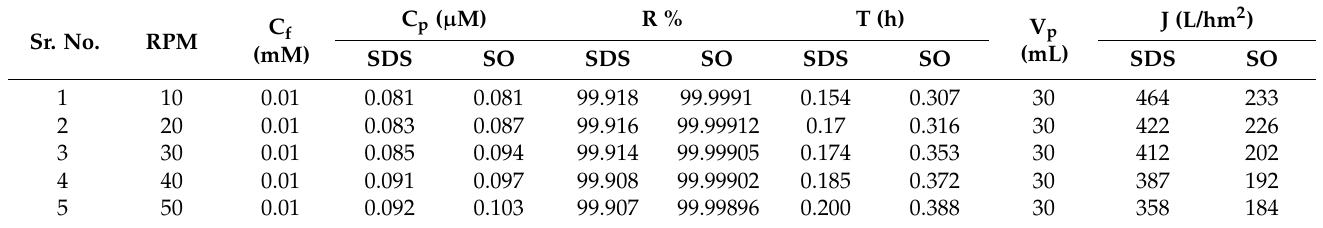
Table 5. Calculation of rejection coefficient (R%) and permeate flux (J) of Co 2+ against different RPM values in solution of SDS and SO, at fixed Co 2+ concentration in feed (C f ), Co 2+ concentration in permeate solution (C p ), filtration time (t), permeate volume (V p